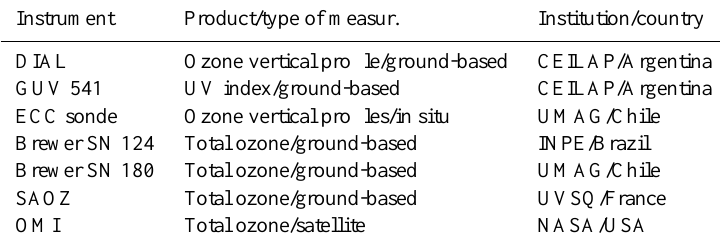
Table 1. List of instruments considered in this study. Instrument Product/type of